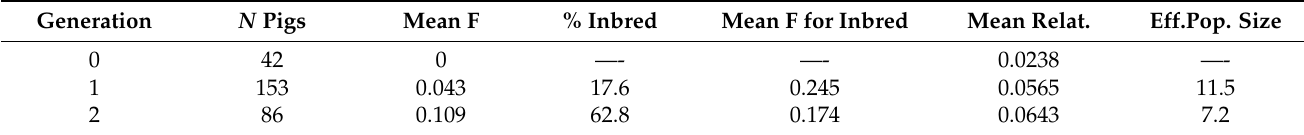
Table 3. Inbreeding coefficient, relatedness and effective population size of the three generations traced in Nero Lucano pigs.